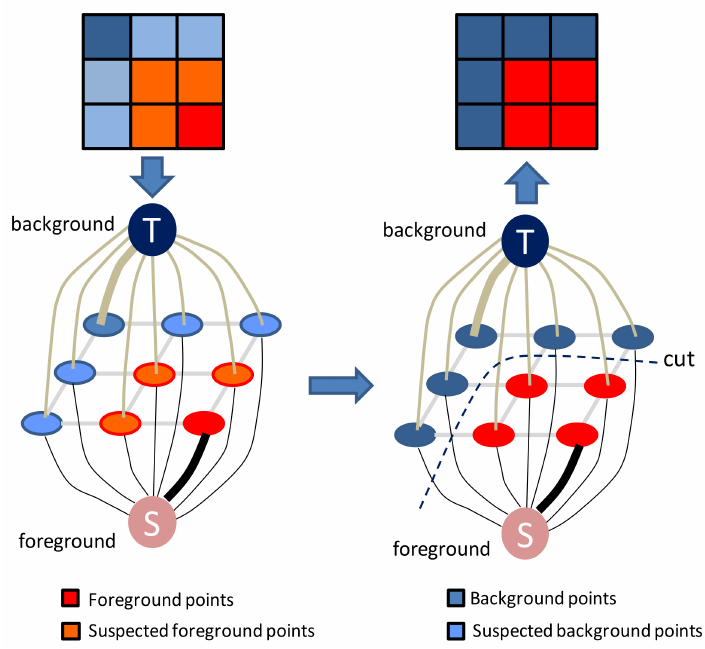
Figure 2. Workflow of binary-classification graph